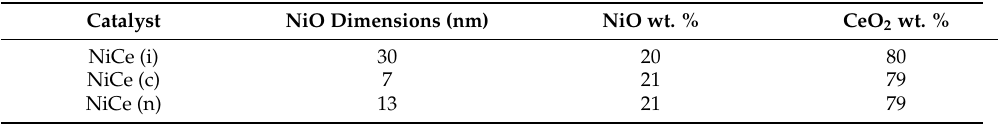
Figure 4. XRD spectra of the catalysts. Table 2. NiO crystallite dimensions obtained by XRD analysis using the Scherrer equation; phase composition of the catalysts determined via XRD.